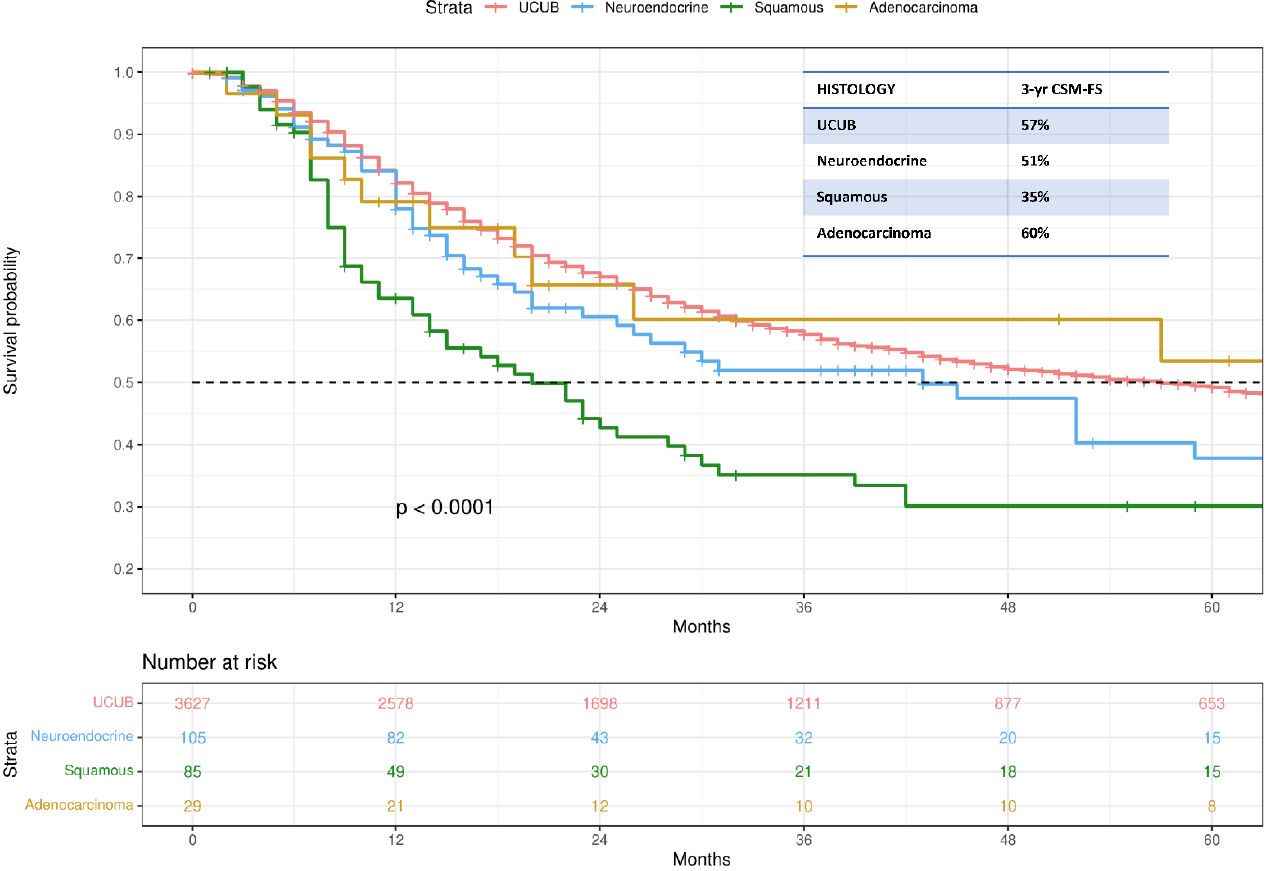
Figure 1. Kaplan–Meier analyses depicting cancer-specific mortality-free survival (CSM-FS) estimates of 3846 T2N0M0 bladder cancer patients identified within the Surveillance, Epidemiology, and End Results database (2000–2018). Data were stratified according to histology; UCUB: urothelial carcinoma of the urinary bladder.